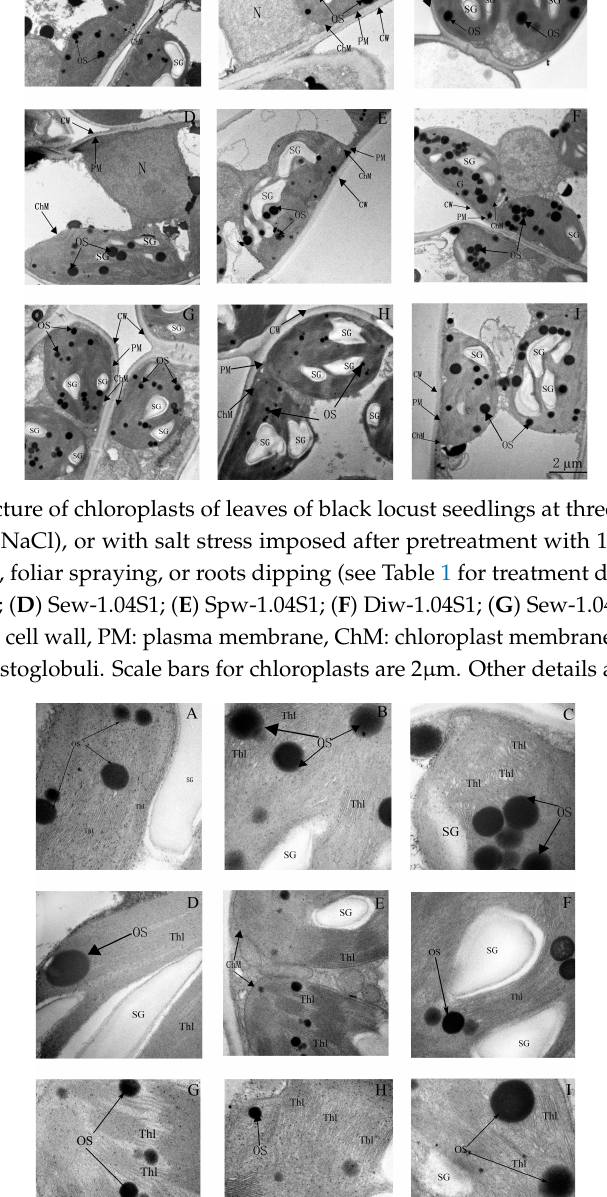
thylakoids are 1 µ m. Other details are the same as Figure